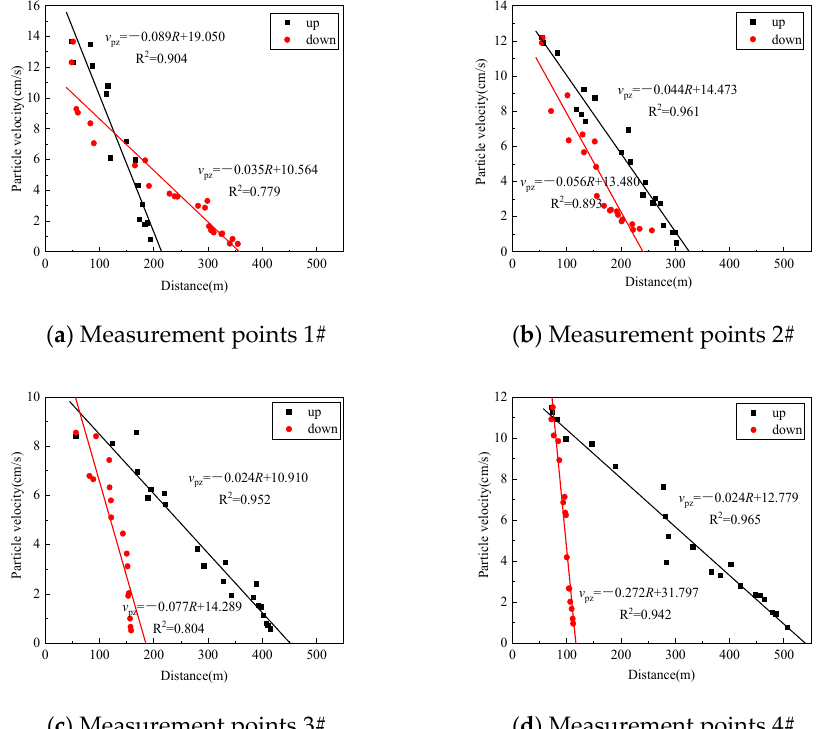
Figure 8. Fi tt ing line between particle velocity and distance in the Z direction. Figure 8. Fitting line between particle velocity and distance in the Z